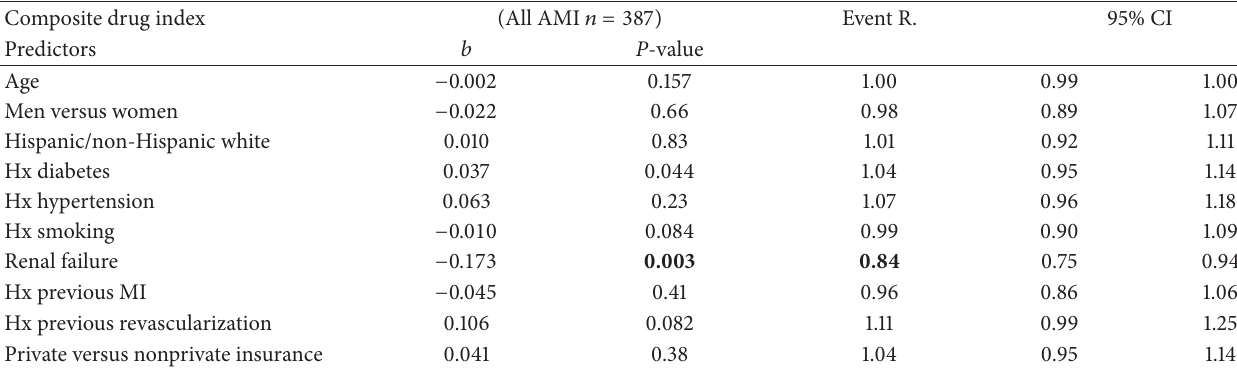
Table 4: Events rates (Poisson regression) in Hispanic and non-Hispanic patients with a confirmed AMI for a composite drug use by multivariable logistic regression of the listed predictors.